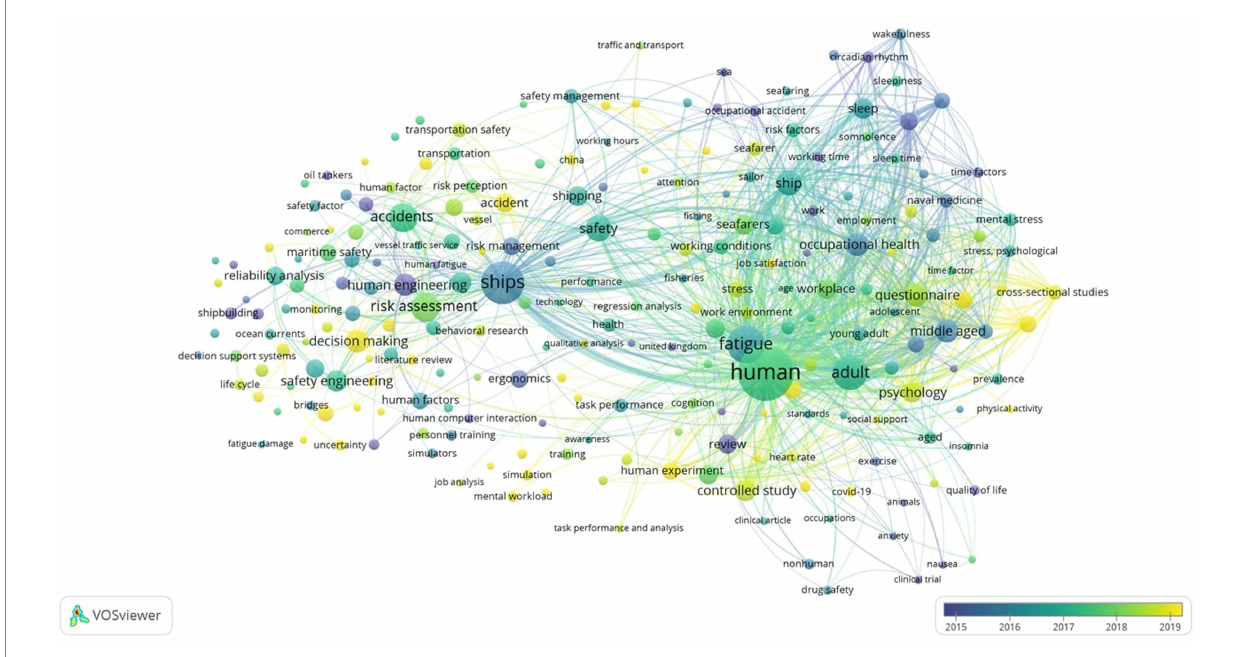
FIGURE 2 Overlay visualization of co-occurrence analysis from 2014 to 2022 (Source VosViewer).